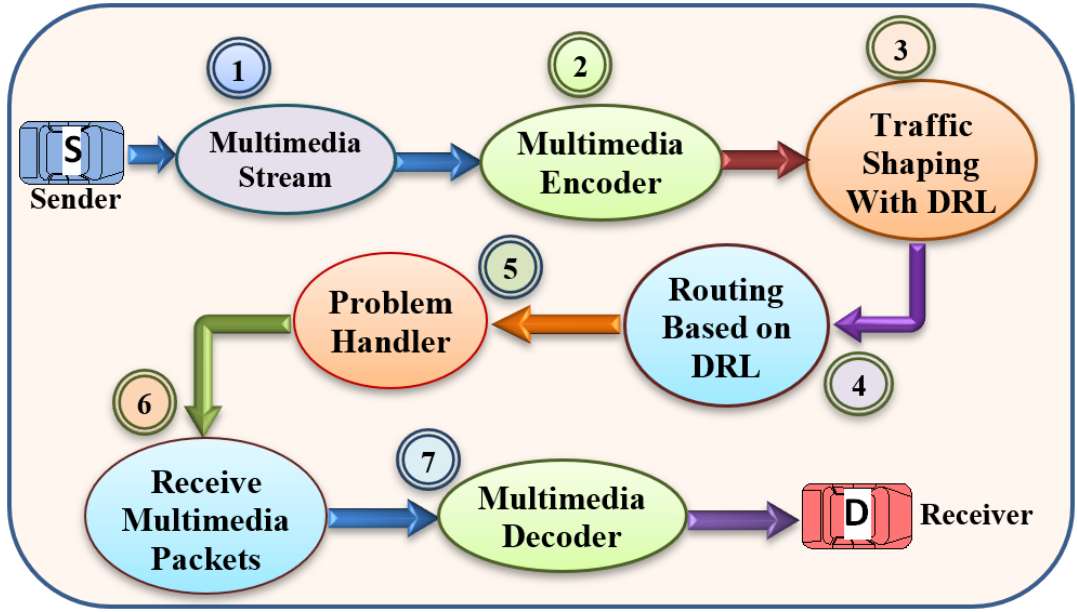
Figure 2. RMDRL System